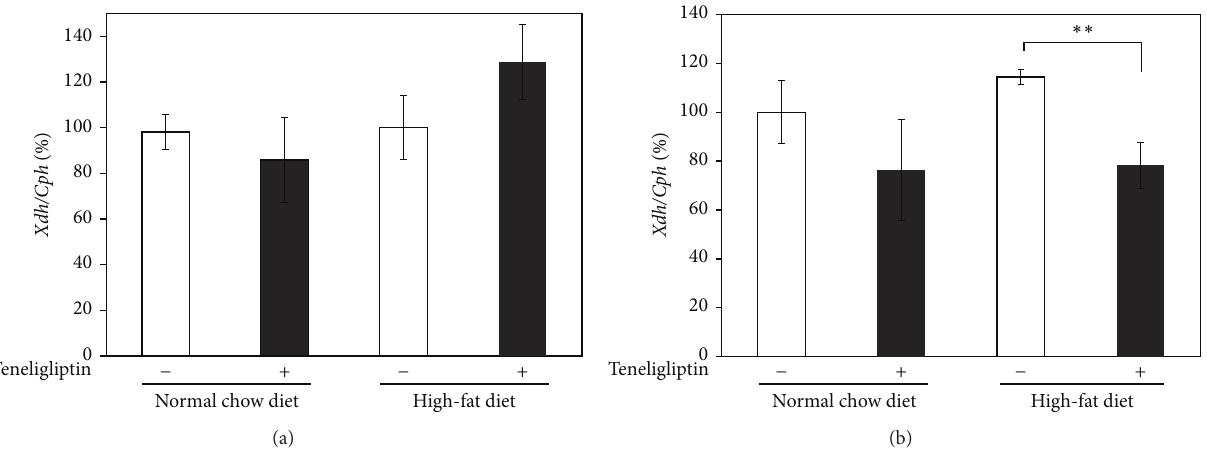
Figure 2: Effects of teneligliptin on xanthine dehydrogenase (Xdh) in liver (a) and epididymal adipose tissues (b) of male Wistar rats. Total RNAs extracted from liver tissue and epididymal adipose tissue of the control group ( ◻ : NCD-fed rats: 𝑛 = 10 , HFD-fed rats: 𝑛 = 9 ) and the teneligliptin group ( ◼ : NCD-fed rats: 𝑛 = 9 , HFD-fed rats: 𝑛 = 9 ) were used for gene expression analysis of Xdh. Levels of Cph were used for normalization of sample loading. Data are the means ± SEM. Data are expressed relative to NCD-fed control values. ∗∗ 𝑃 < 0.01 versus control